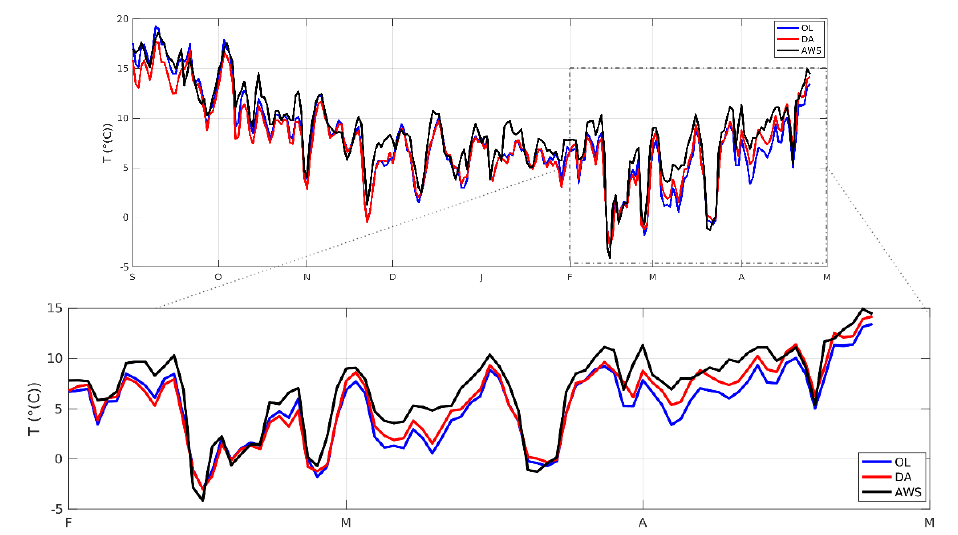
Figure 13. Evolution of the mean air temperature over the Rheraya catchment during (i) all season (ii) melt season. AWS refers to automatic weather station, OL refers to open loop simulation and DA refers to data